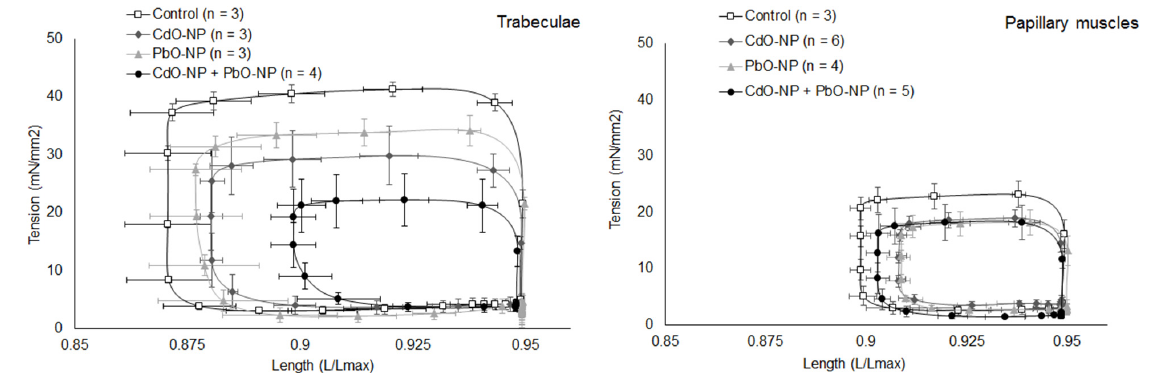
Figure 6. Representative examples of the length–tension loops obtained for isolated trabeculae (left panel) and papillary muscles (right panel). Data are shown as mean ± s.e. Statistical analysis was carried out for work values calculated using the data on length–tension loops.